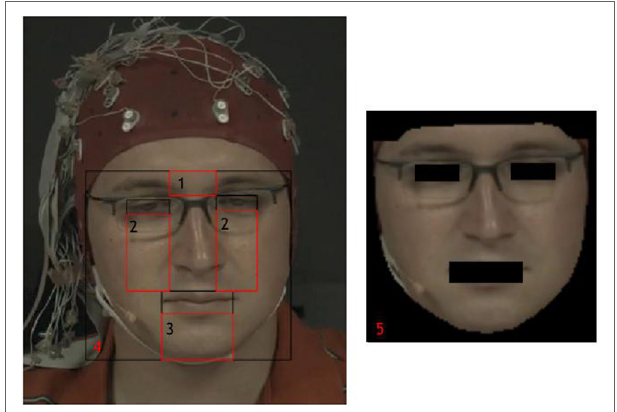
FigURe 5 | Face segmentation (1. Forehead; 2. Cheeks; 3. Chin; 4. Whole face; 5. Extracted